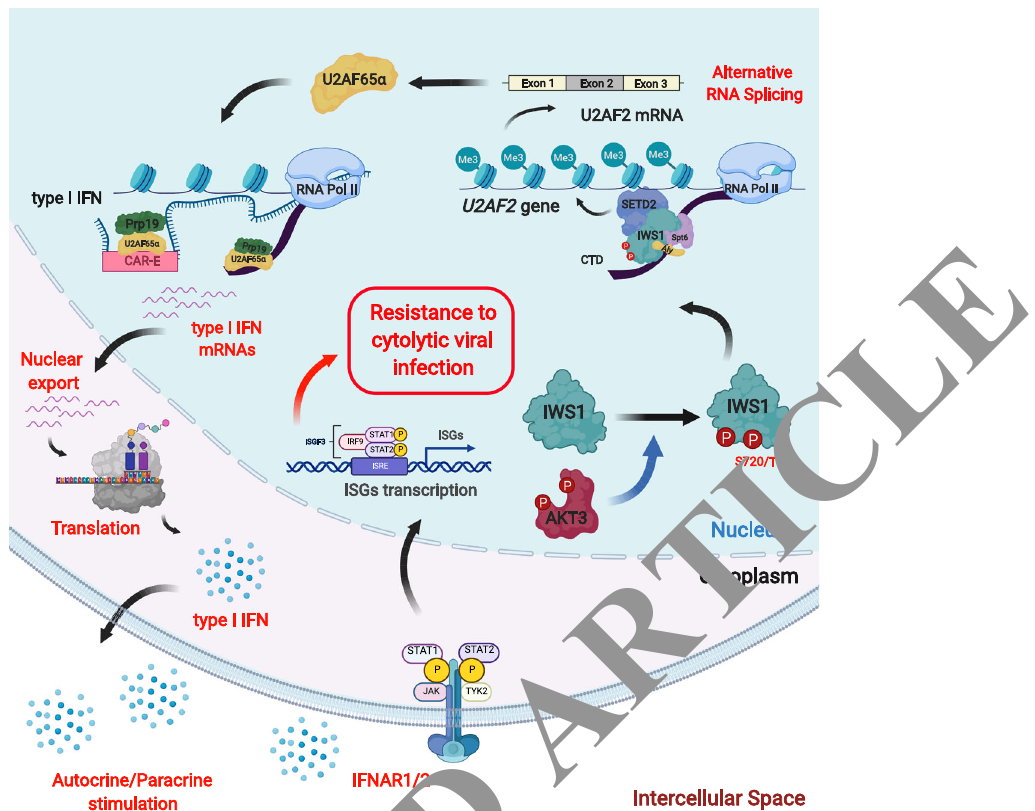
Fig. 8 The AKT3/IWS1/ U2AF2 axis promotes the nuclear export of the mRNAs of CAR-Element-containing intronless genes and inhibits infection of cancer cell lines by cytolytic viruses. The phosphorylation of IWS1 at S720/T721 by AKT controls the epigenetic regulation of the alternative RNA splicing of U2AF2 , promoting the inclusion of exon 2 in the mature U2AF2 mRNA. The RS domain-containing U2AF65 α encoded by the exon 2 containing U2AF2 mRNA, is loaded to CAR-Elements in the mRNA of type I IFNs, and other CAR-Element-positive intronless genes via RNA Pol II, and recruits Prp19. The U2AF65/Prp19 complex assembled on the CAR-Elements is required for the nuclear export of these mRNAs. Overall, IWS1 expression and phosphorylation by AKT, enhances the abundance of the proteins encoded by CAR-Element-positive intronless genes, including type I IFN genes and increases the resistance of the cells to infection by cytolytic viruses. The schematic was created with Biorender.com under the third-party publication license permission